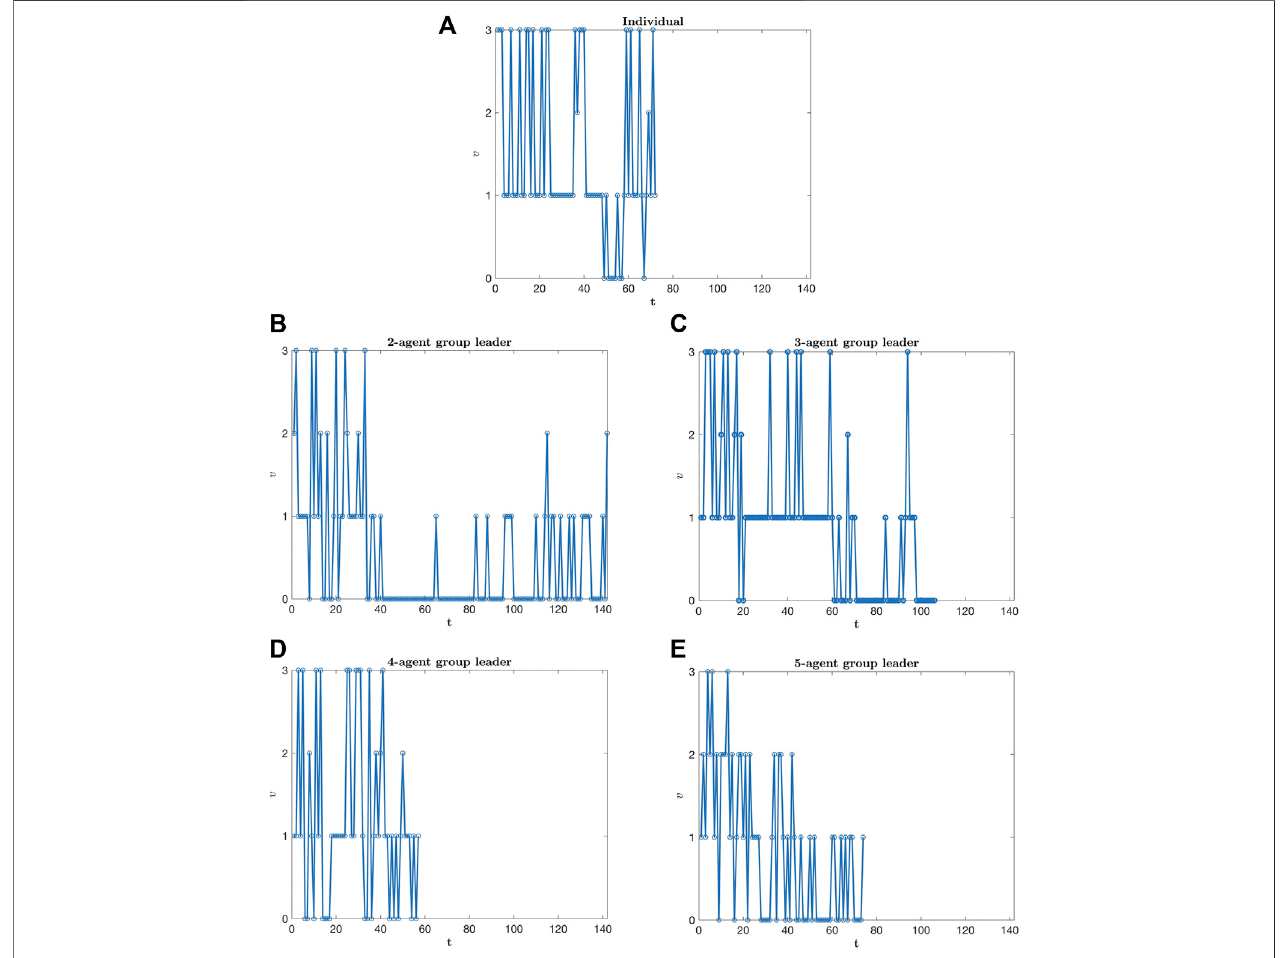
FIGURE A1 | Intermittent jams during evacuation for a speci fi c agent [individual with v (cid:2) 3 (A) , 2-agent group leader with v (cid:2) 3 (B) , 3-agent group leader with v (cid:2) 3 (C) , 4-agent group leader with v (cid:2) 3 (D) , 5-agent group leader with v (cid:2) 3 (E) ].